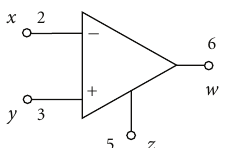
Figure 2: Representations of CFOA of AD 844 type at electric circuits with numeric and corresponding letter symbols of